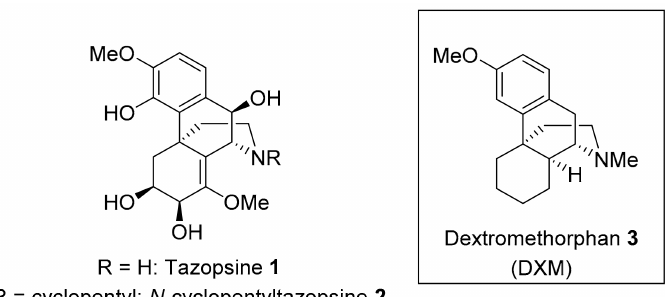
Figure 1. Antiplasmodial ent -morphinans: natural tazopsine 1 , semisynthetic hit 2 , and the prospected DXM 3